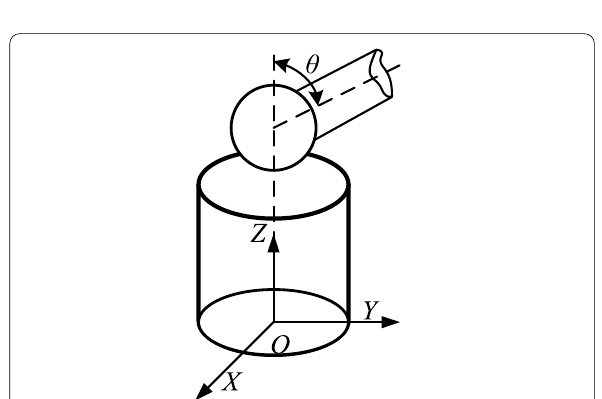
Figure 9 Rotation angle of spherical kinematic